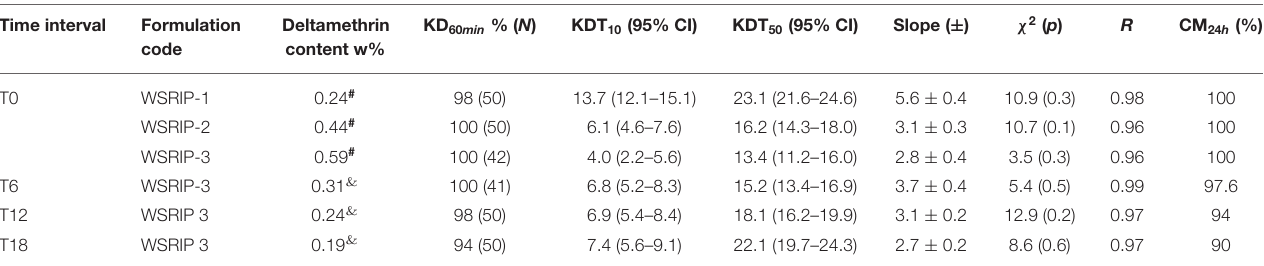
TABLE 4 | Knockdown and 24h delayed mortality in susceptible Ae. aegypti for different formulations. Time interval Formulation